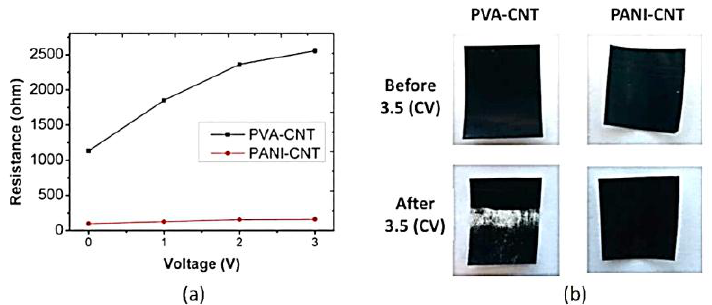
Figure 12. ( a ) Resistance and ( b ) stability in PANI/CNT–COOH and PVA/CNT-COOH membranes. Reprinted from [122], with permission from American Chemical Society.